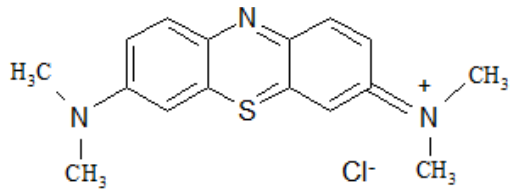
Fig. 1. Physical properties and molecular structure of Methylene blue